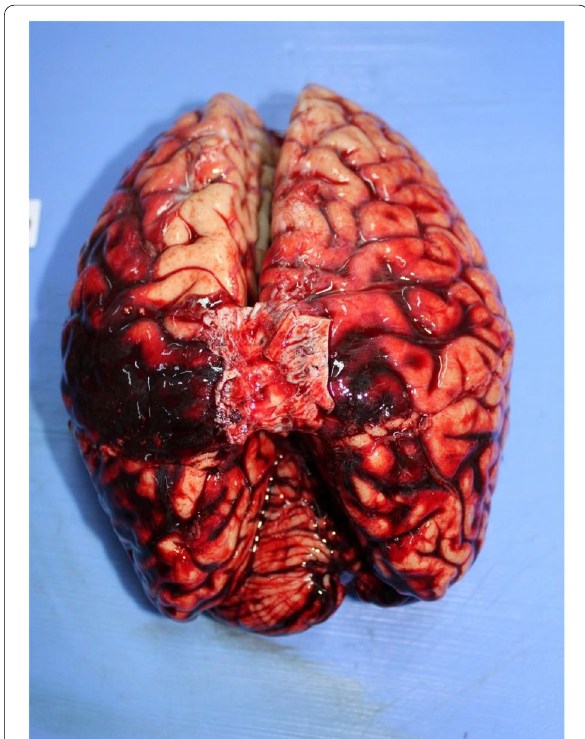
Fig. 3 Diffuse subarachnoid haemorrhage and left parieto-occipital subdural haematoma